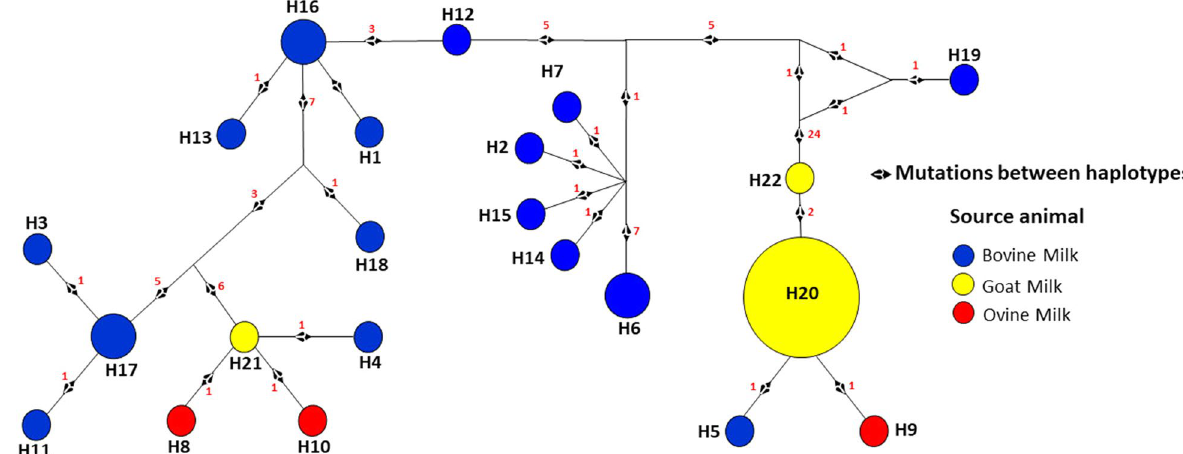
Figure 4. Haplotypical network of multilocus sequence typing alleles arcC , aroE , gmk , pta , tpi , glpF e yqiL of Staphylococcus aureus obtained from milk of animals with mastitis. Hosts: Yellow—Caprine; Blue—Bovine; and Red—Sheep. Red numbers between haplotypes—polymorphic sites. The colors separating the haplotypes refer to the groups formed in the MS tree. Constructed with Network 4.6.1.0 software.